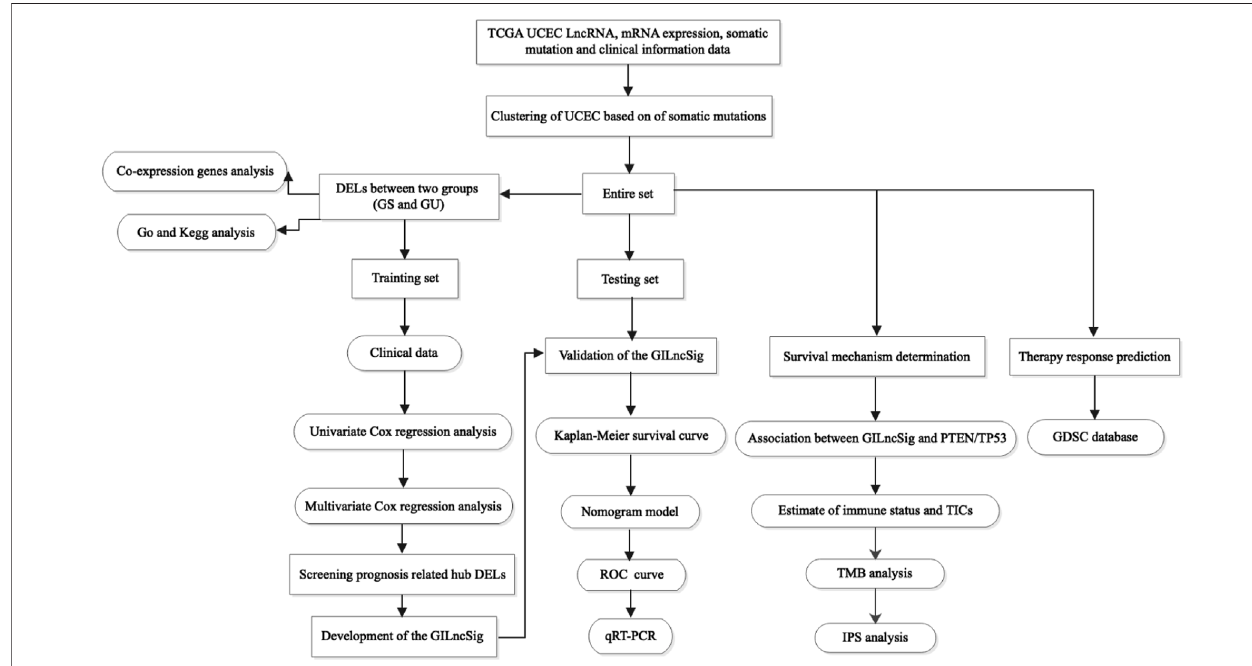
FIGURE 1 | Research roadmap of this